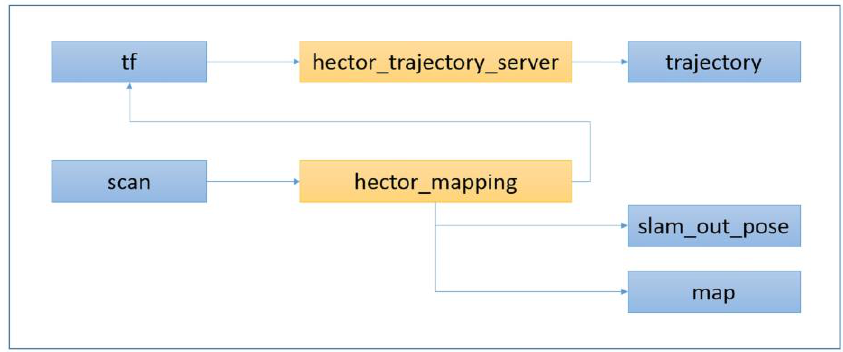
Figure 3. Hector SLAM scheme: nodes (yellow) and topics (blue).